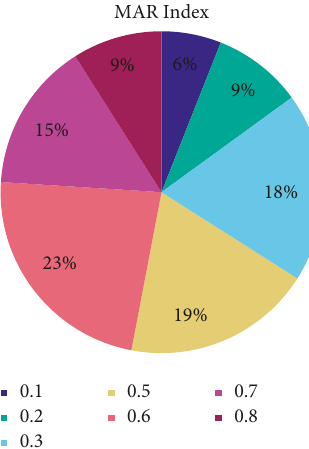
Figure 3: Graphical representation for multiple antimicrobial resistance in E. coli